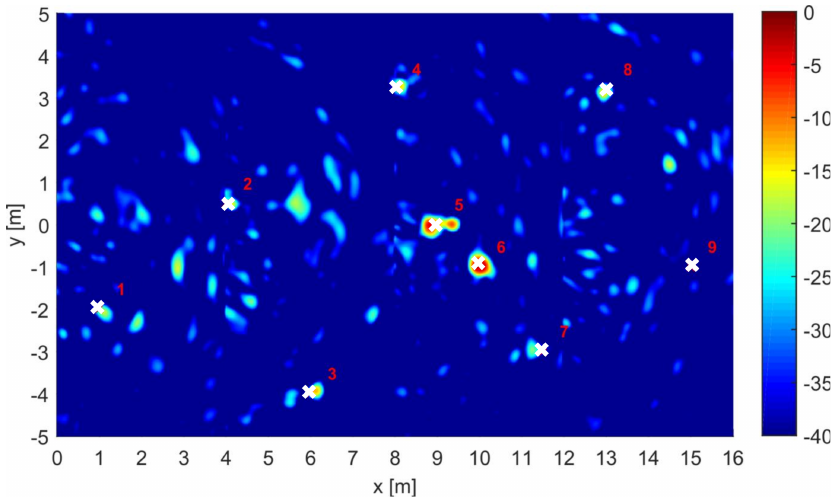
Figure 9. BP image of Figure 6 after application of the amplitude coherence factor (ACF)-based enhancement procedure. The target position and type are indicated with a white cross and